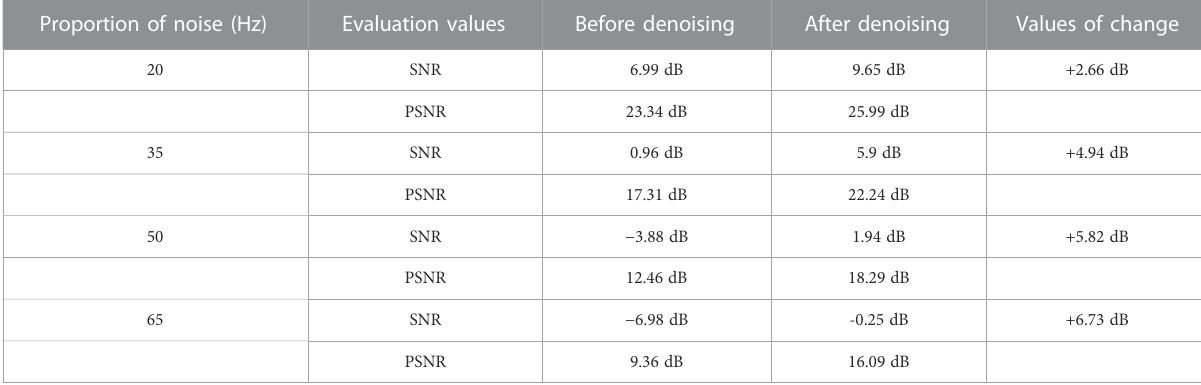
TABLE 4 Evaluation values for different